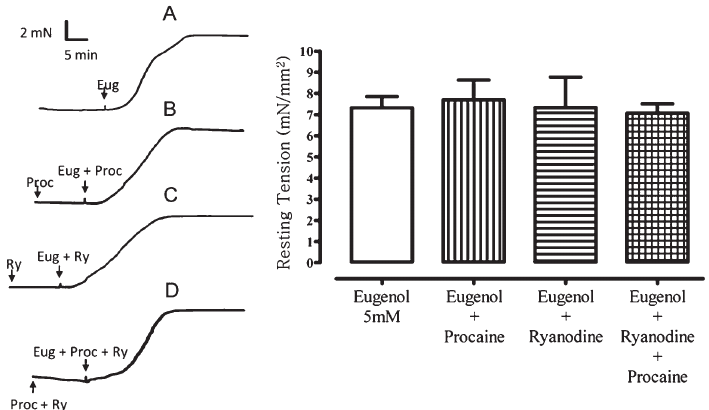
Figure 2. Effect of eugenol (Eug) on the resting tension of atria trabeculae of the rat in the absence ( A ) and in the presence of procaine (Proc) ( B ), ryanodine (Ry) ( C ) or both, procaine and ryanodine ( D ). The experiments were carried out in normal Ringer solution. No significant differences in force were observed among groups (P . 0.05, ANOVA followed by the t -test;